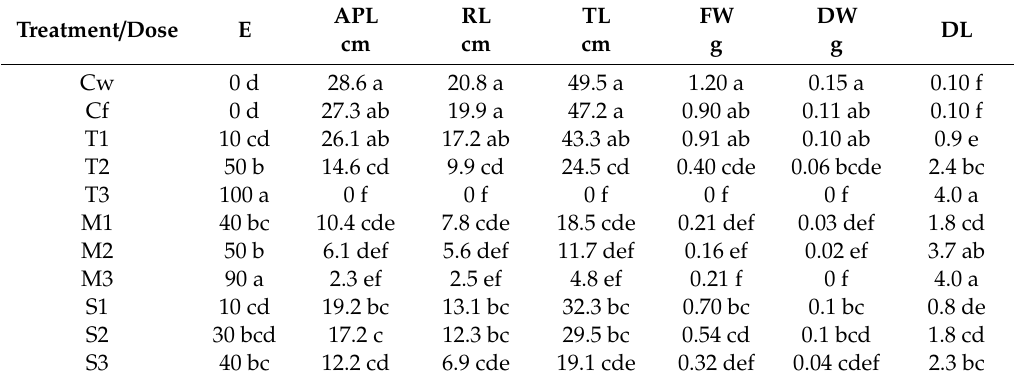
Table 5. Effects of T. capitata (T1, T2 and T3 are 4, 8 and 12 µ L mL − 1 dose of essential oil), M. piperita (M1, M2 and M3 are 12, 16 and 20 µ L mL − 1 dose of application), and S. chamaecyparissus (S1, S2 and S3 are 12, 16 and 20 µ L mL − 1 dose of application) essential oils applied by irrigation against E. crus-galli on the efficacy (E), plant biometric variables [aerial part (APL), root (RL) and total length (TL), fresh (FW) and dry weights (DW)] and damage level (DL). Cw (only water, neither Fitoil nor EO application), Cf (0.03 µ L Fitoil g − 1 of soil, no EO application). The damage level (DL) was assessed developing a damage scale ranging from 0 (no damage) to 4 (death of the plant). The efficacy (E) of a given EO was considered as its capacity to kill the plants and was assessed by attributing the value 0 if the plant was alive and 100 if the plant was dead. Both DL and E are dimensionless. Data are the arithmetic mean of 10